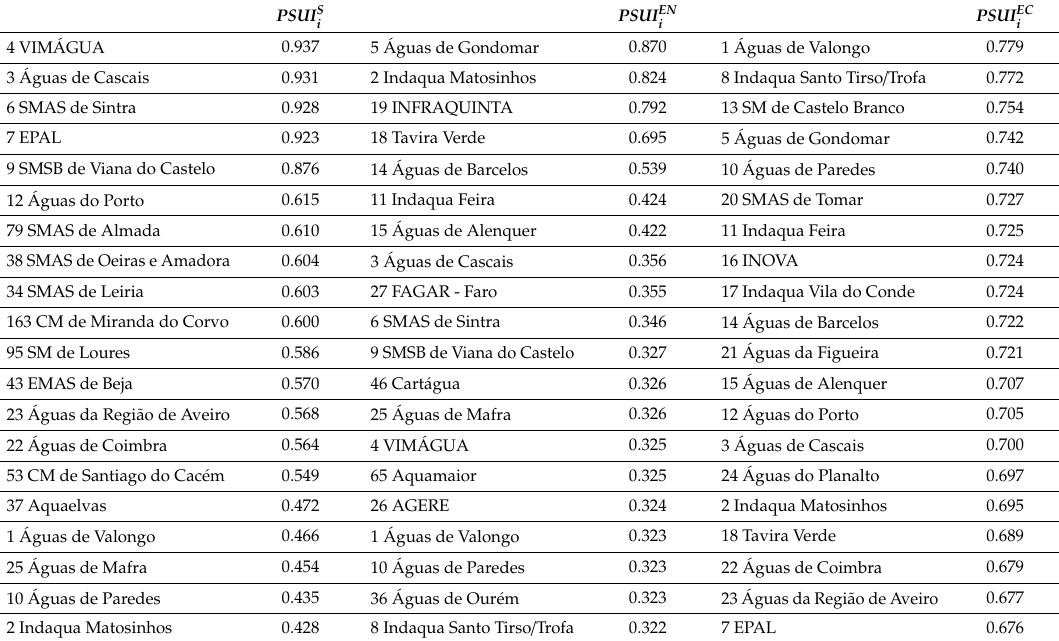
Figure 3. Dimensional results obtained for each of the 163 water companies. Table 3. Top 20 water companies for each